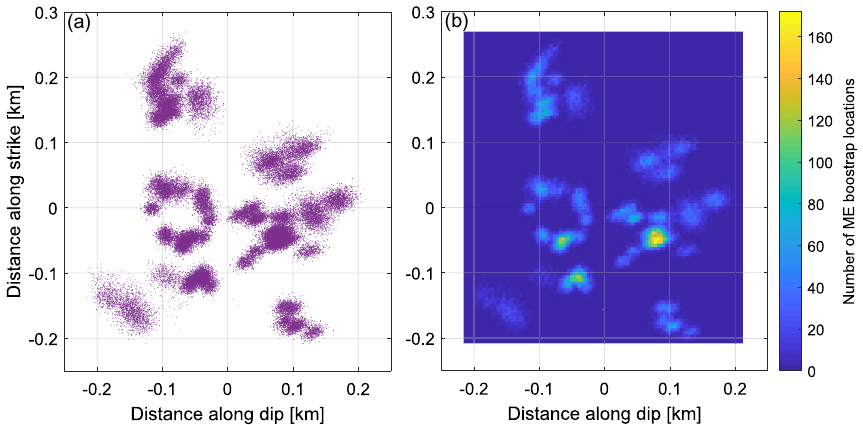
Figure 7. Cross section along the potential fault D plane: ( a ) hypocenters of ME and their bootstrap samples are marked with violet dots, ( b ) density